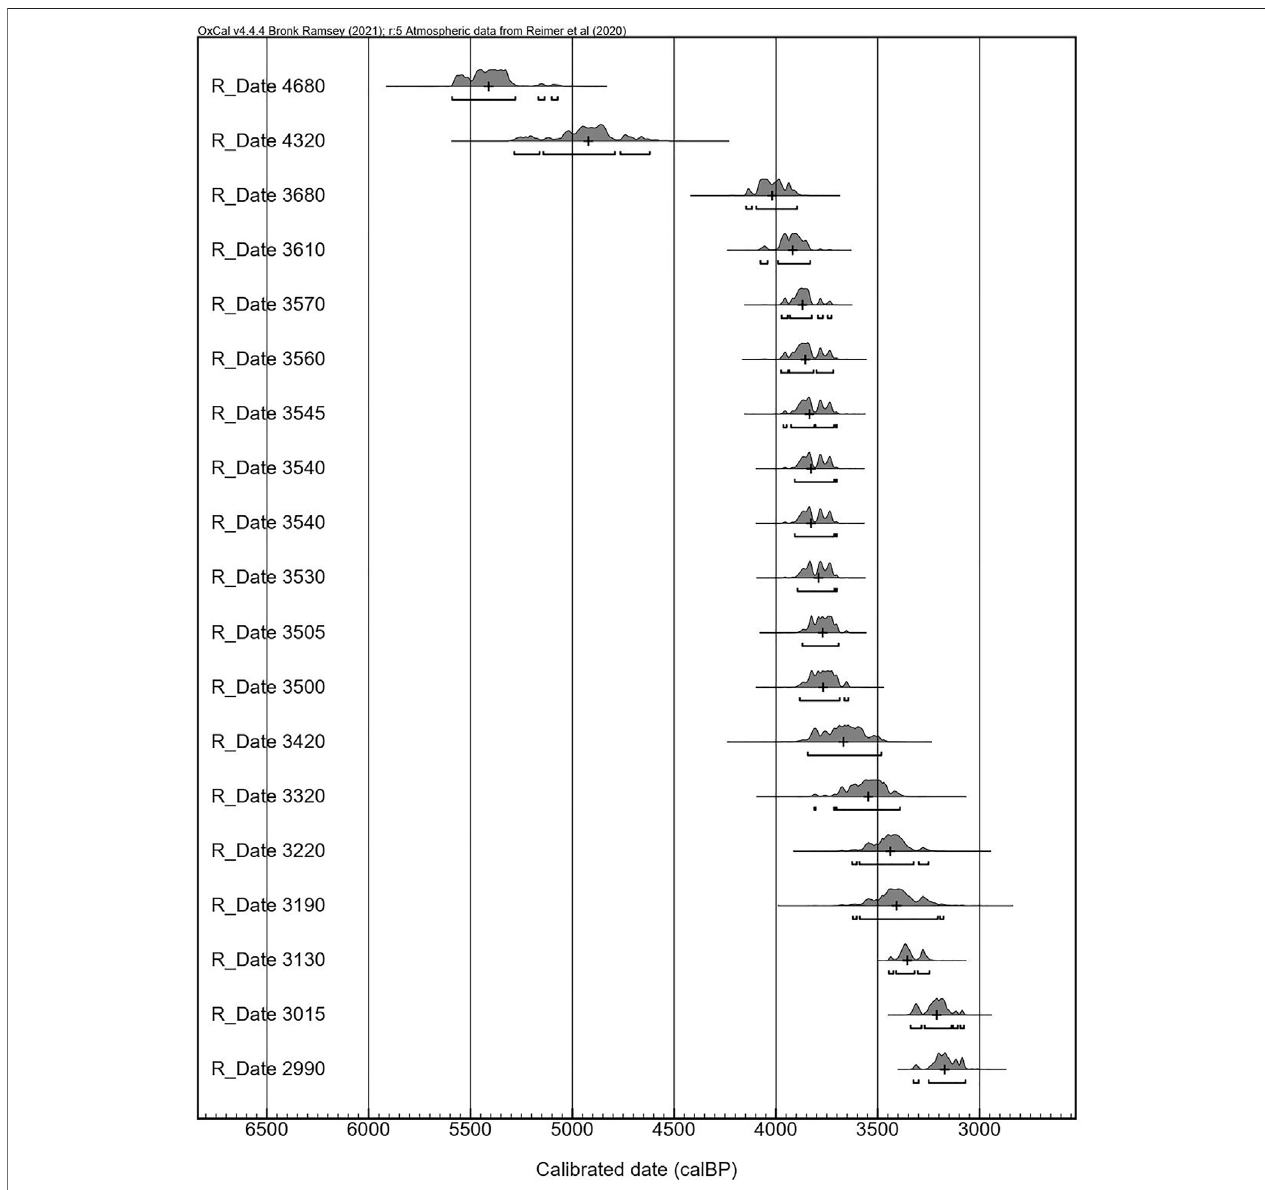
FIGURE2| AMS14CdatingresultsforthesamplesfromtheZKGsite. “ + ” indicatesthemedianage.TheagesweredeterminedusingOXCAL4.3softwarewiththe INTCAL20 curve correction (Reimer et al., 2020).